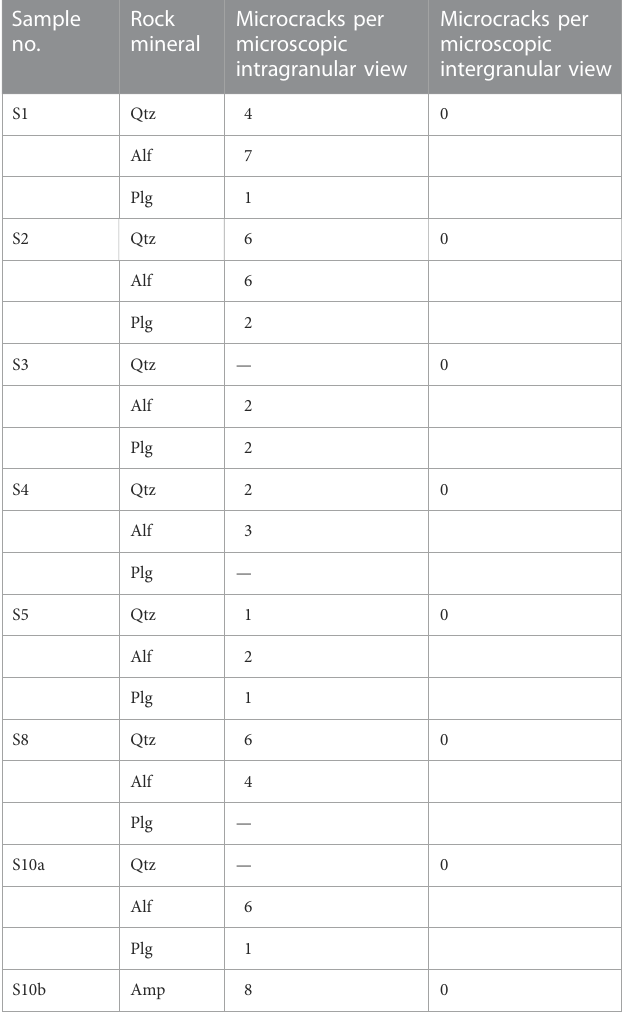
TABLE 7 Microcrack density in major minerals, such as quartz (Qtz), alkali feldspar (Alf), plagioclase (Plg), and amphibole (Amp). Sample